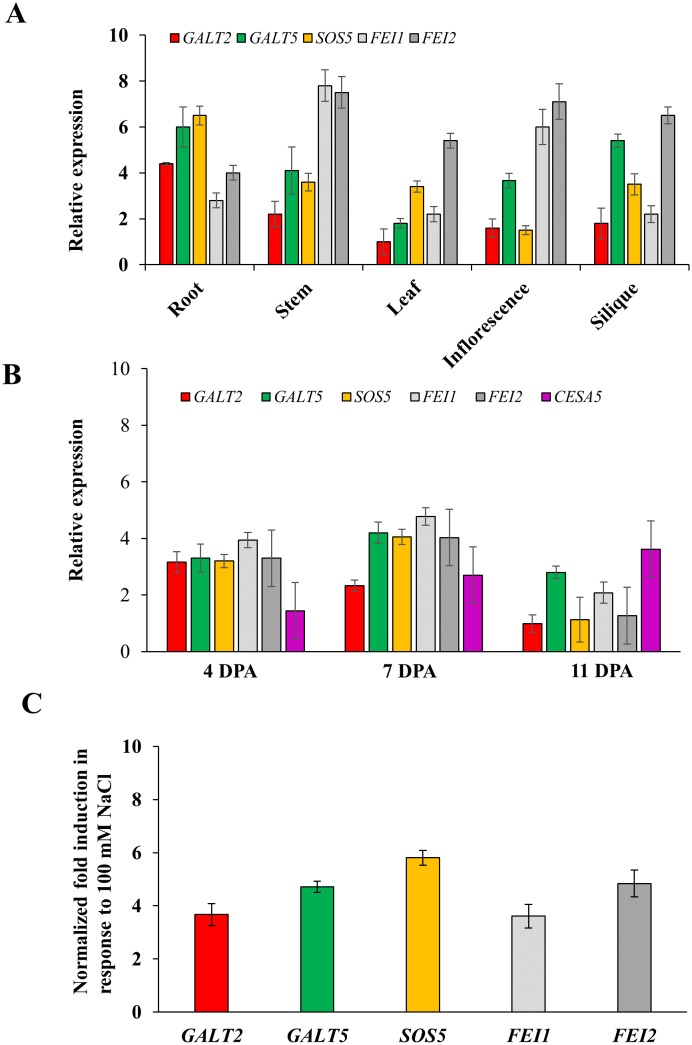
Transcript profiling of GALT2, GALT5, SOS5, FEI1, and FEI2 genes in different organs/tissues and in response to salt treatment.(A) qRT-PCR analysis of the five genes in different plant organs/tissues. Expression levels are the mean ± SE of three technical replicates relative to the Ubiquitin 10 (UBQ10) reference gene. The expression value of GALT2 in leaf was considered as 1. (B) Expression analysis of the five genes during the course of seed development. Total RNA was isolated from seeds 4, 7, and 11 DPA. Relative expression was normalized using GAPC as a reference gene. The expression value of GALT2 at 11 DPA was considered as 1. C. Induction of transcript abundance of GALT2, GALT5, SOS5, FEI1, and FEI2 in response to salt treatment. Total RNA was extracted from root tips of 250 WT and mutant seedlings grown in MS media and in MS media supplemented with 100 mM NaCl for 7d. Experiments in (B) and (C) are the mean ± SE of three technical replicates.